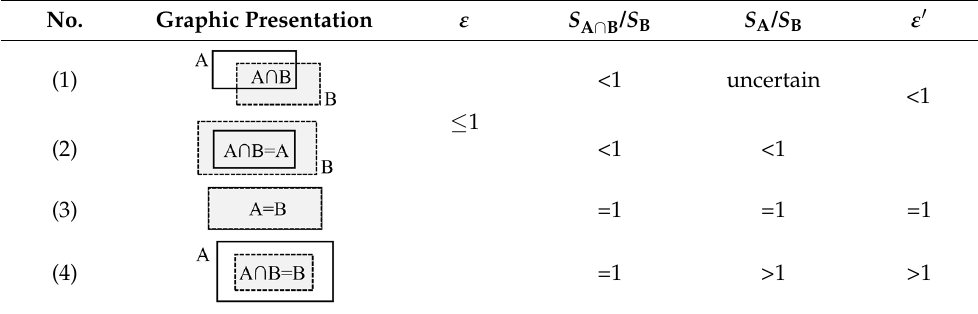
Table 14. Calculation method of the relative accuracy ε and the accuracy index ε ′ .